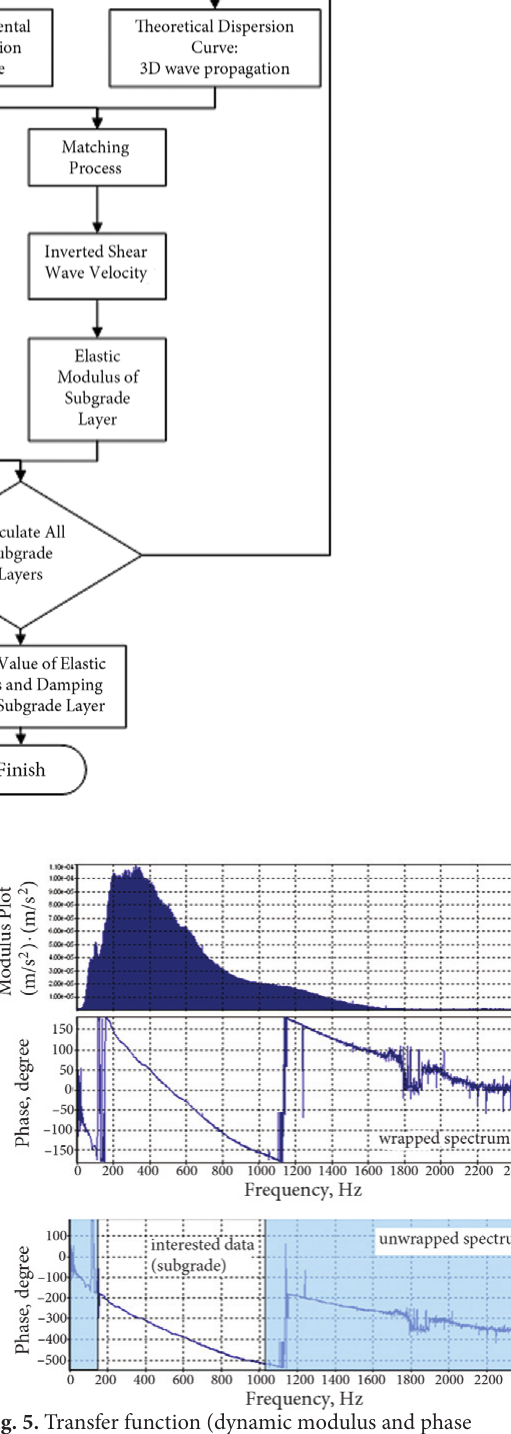
fig. 5. Transfer function (dynamic modulus and phase information) obtained from measurement at 100 cm receiver spacing and its unwrapped phase spectrum with data of interest for the subgrade